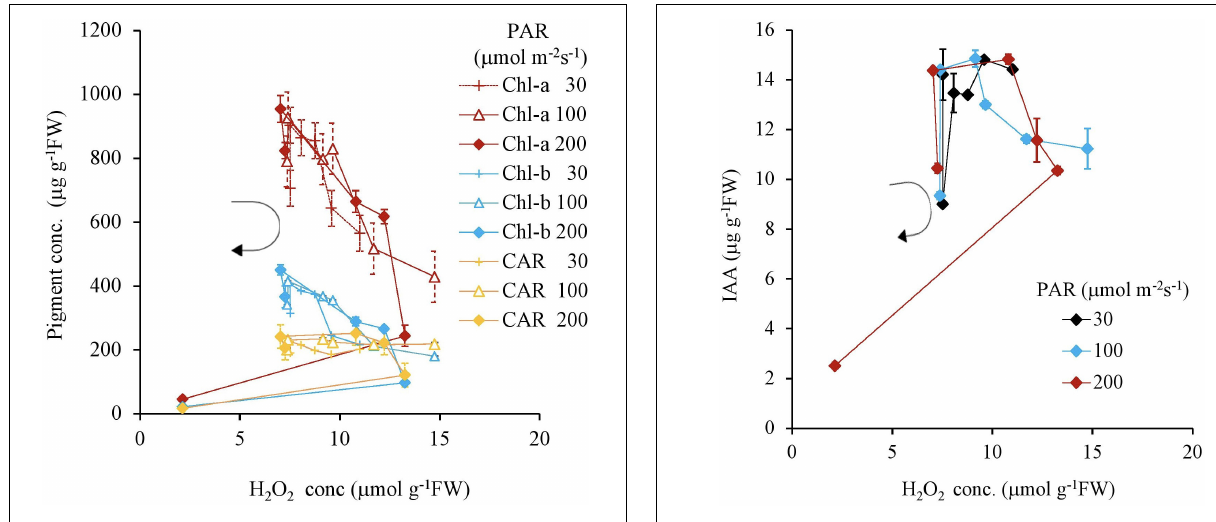
FIGURE 4 | The relation between H 2 O 2 and pigment concentrations of plant tissues after 7 days experiment as a function of Fe concentration in water and PAR intensities. The round arrow indicates the variational trend with increasing Fe concentration. Vertical bars indicate the standard deviation.